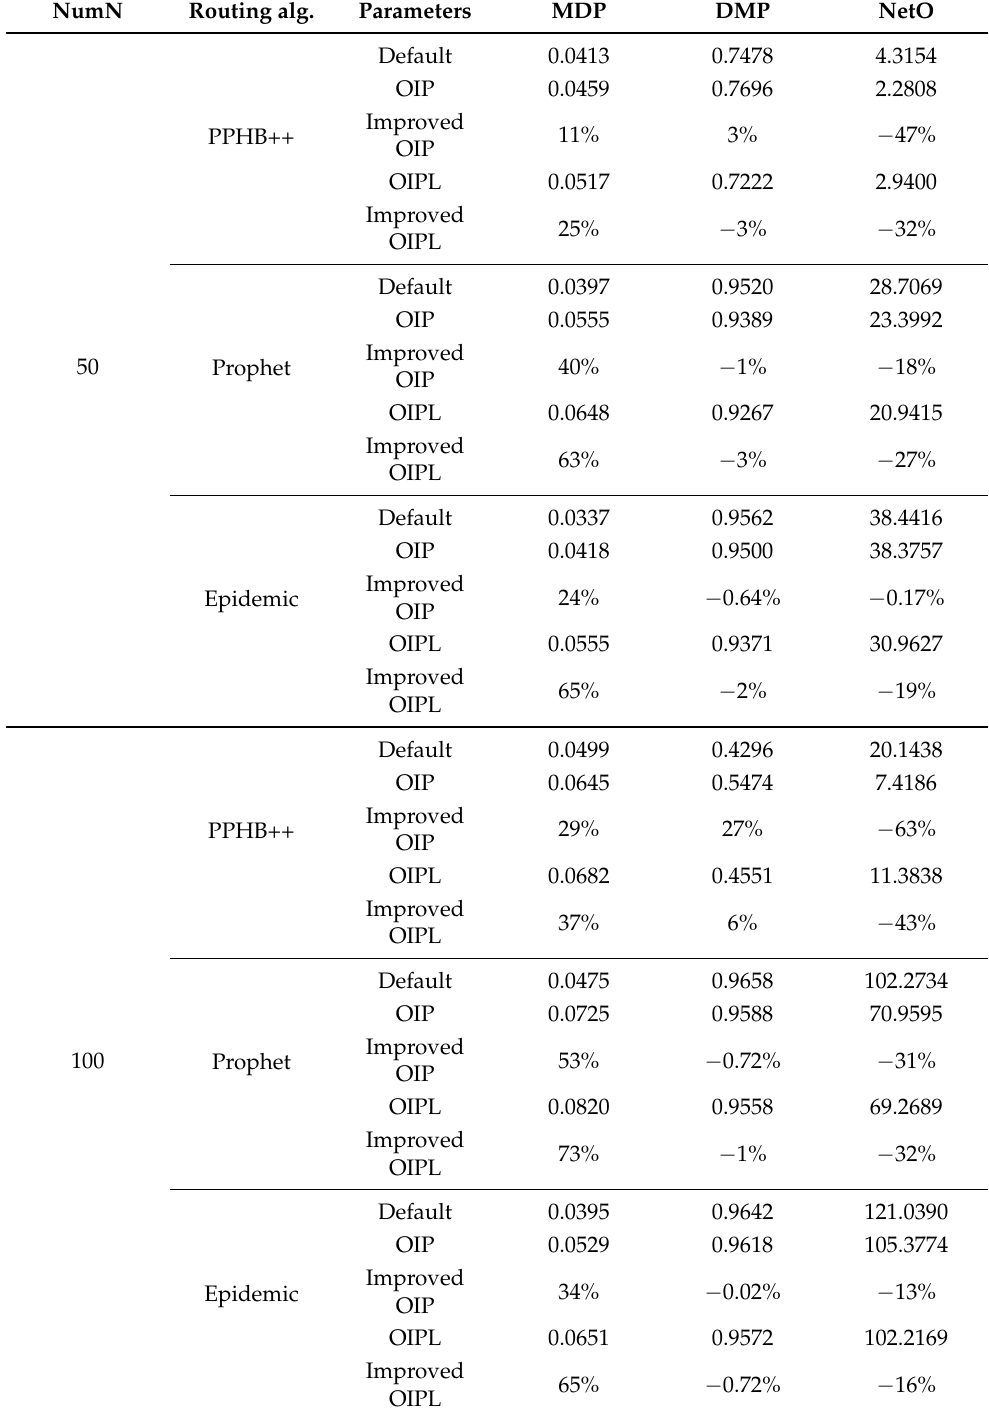
Table A3. Comparison of ONE default setting with optimized parameters for Münster